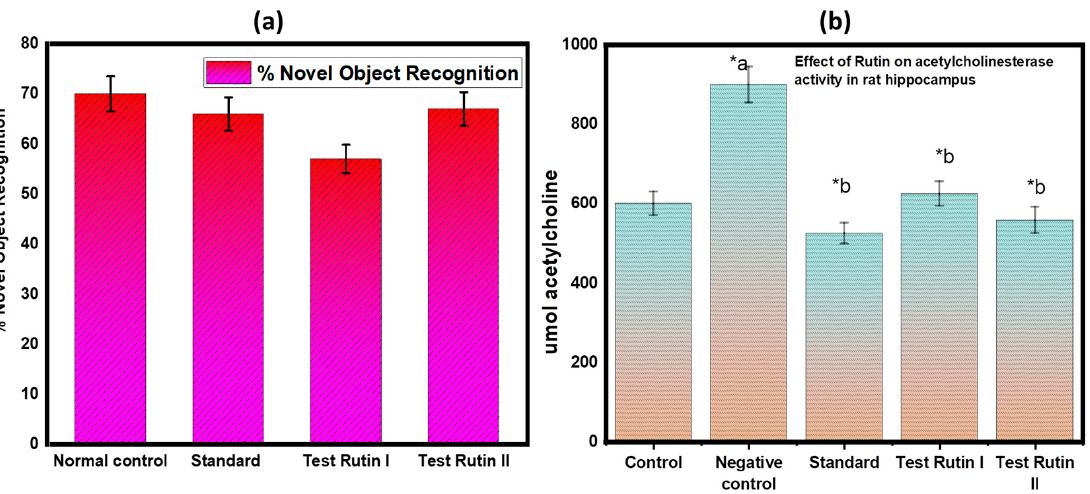
Figure 6. ( a ) Novel object recognition test; ( b ) In vitro assay for acetylcholinesterase activity. The results are expressed as mean ± SD values ( n = 6). The significance of the difference was determined by two-way ANOVA; * p < 0.05 vs. respective controls. a = normal control vs. reserpine control; b= reserpine control vs. test.